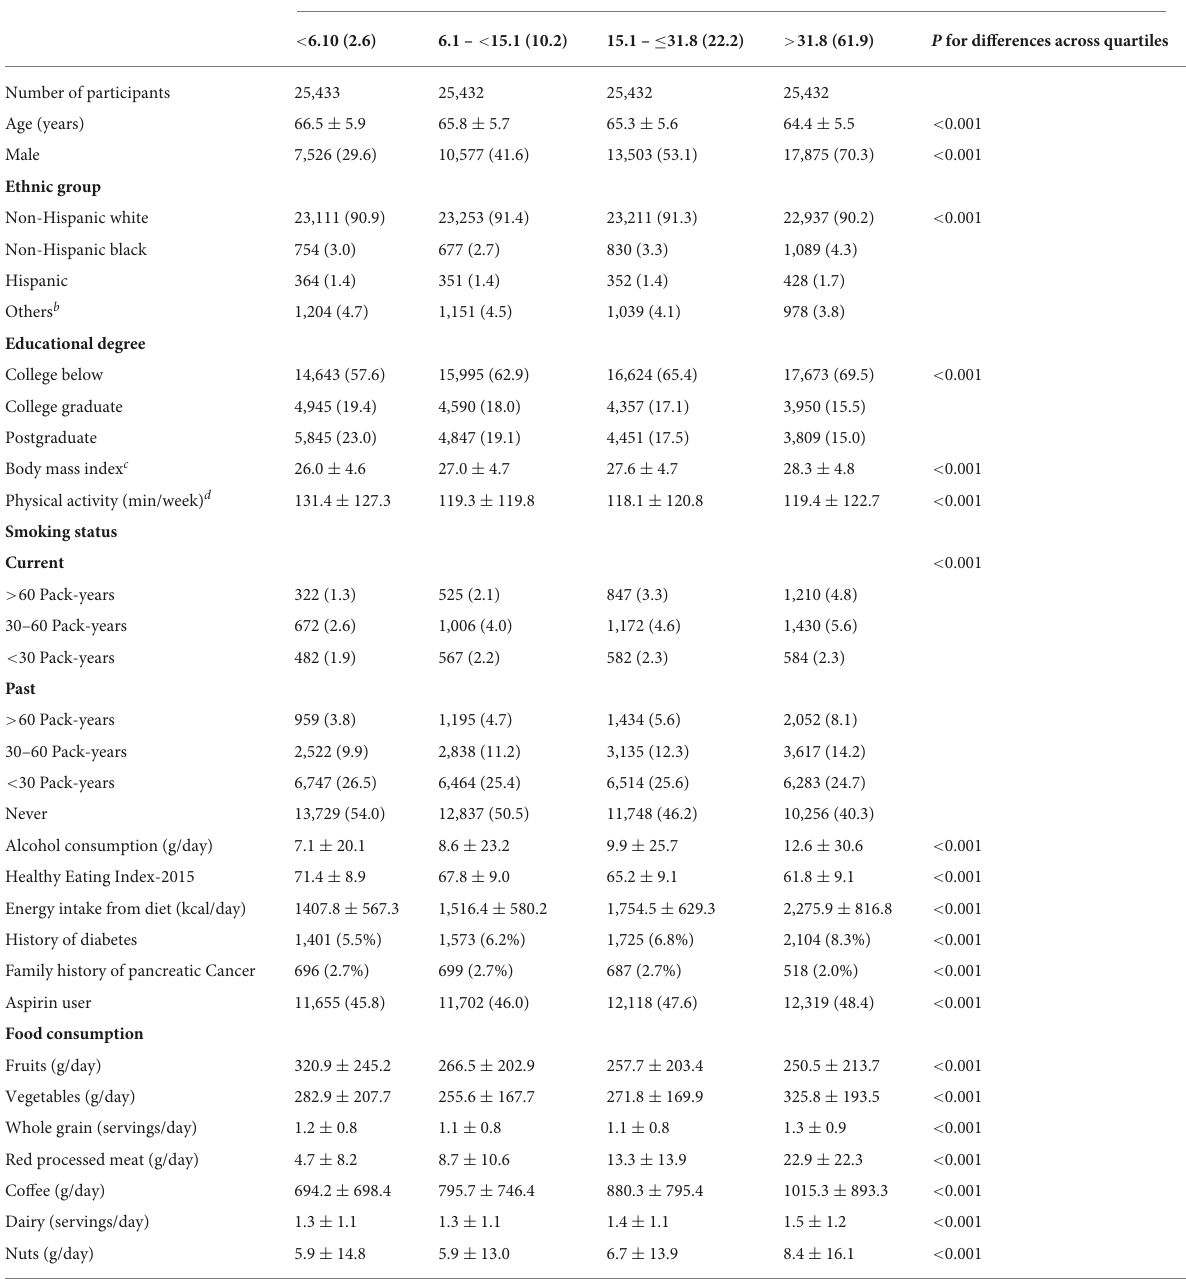
TABLE 1 Characteristics of study population based on quartiles of energy-adjusted total fried food consumption a .